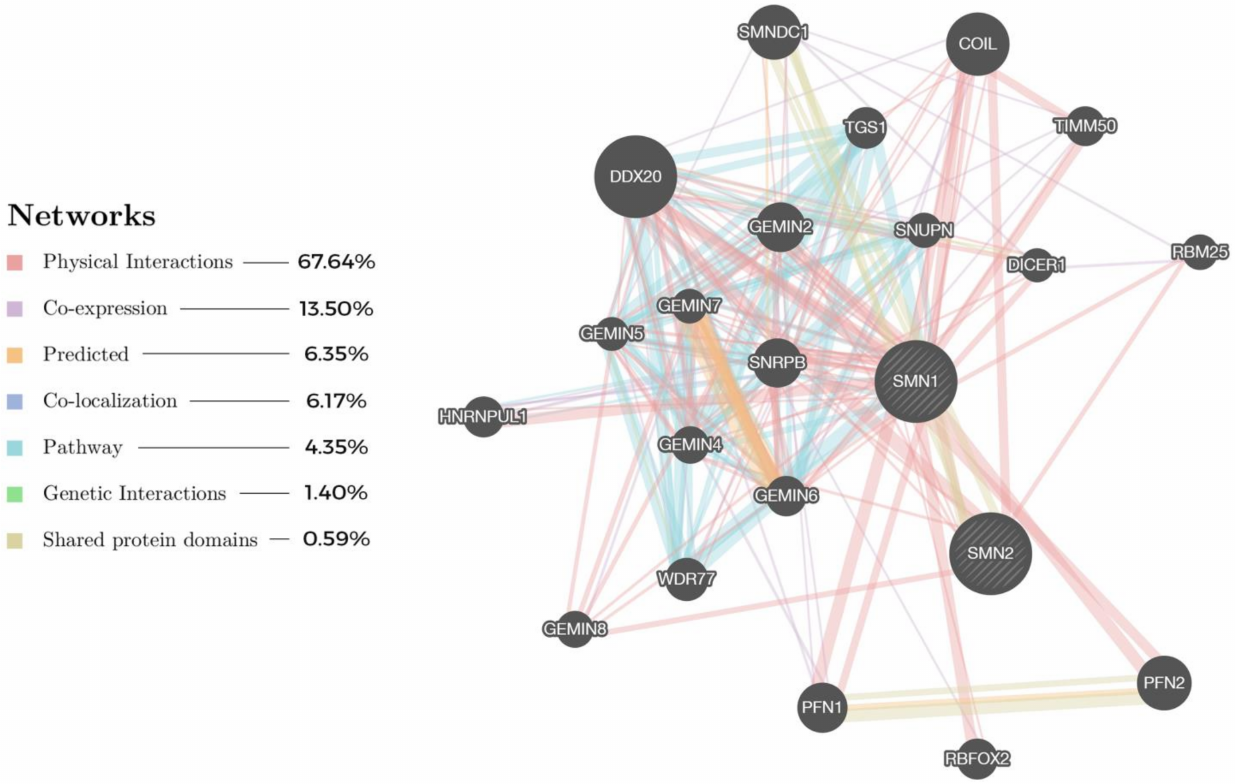
Figure 7. Protein network based on two main proteins, SMN1 and SMN2, and their respective interactions with other proteins related to SMA, generated using GeneMANIA [223] (https://genemania.org/ (accessed on 29 December 2020)). The most prevalent network relationship, reported by literature, among the proteins is physical interactions (pink color) at 67.64%, as visually shown by the line thickness, while the smallest belong to the shared protein domains at